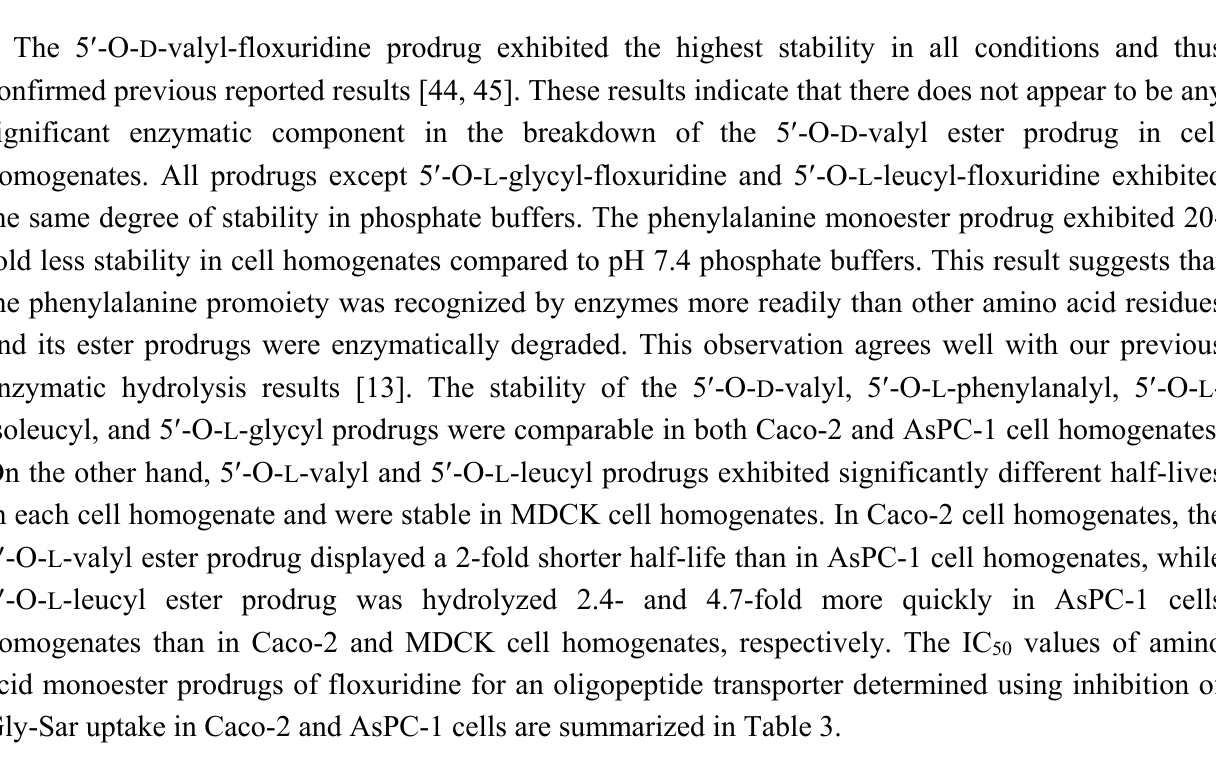
Table 3. Concentrations of floxuridine and floxuridine prodrugs required to inhibit Gly- ) in Caco-2 and AsPC-1 Sar uptake by 50 % (IC 50